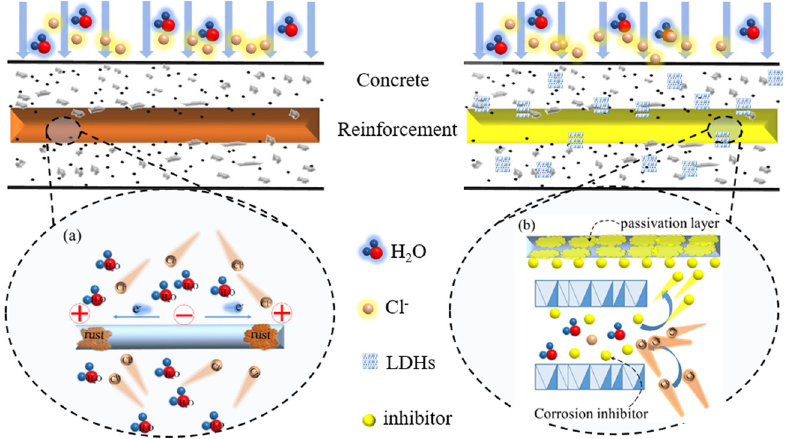
Figure 10: Chloride ions corrosion of reinforcement and corrosion inhibition mechanism of modi fi ed LDHs: ( a ) reinforcement corrosion induced by chloride ions; ( b ) dual - role mechanism of modi fi ed LDHs in reinforced concrete exposed to chloride